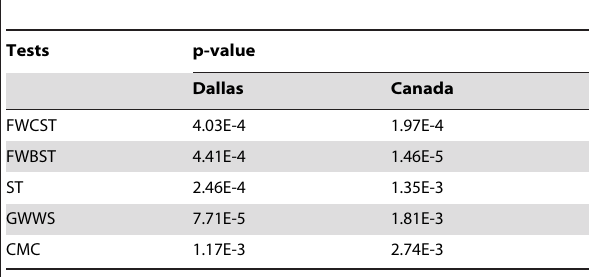
Table 3. Analyses of the real sequence